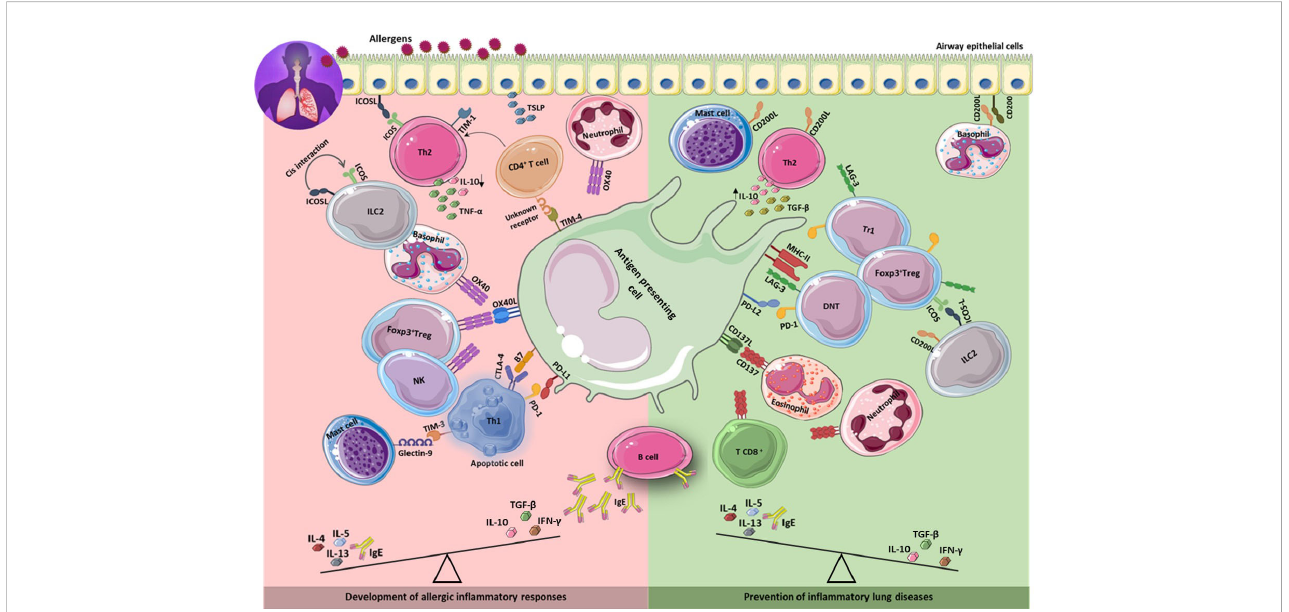
FIGURE 1 Immune checkpoints in the development and prevention of asthma. The development of asthma is associated with increased Th2 response results in secretion of IL-4, 5, 13, and IgE production. Inhibitory and stimulatory immune checkpoint molecules expressing on different immune cells as well as on lung epithelium, contribute to development (left) or prevention (right) of allergic in fl ammatory responses through interaction with their ligands on different cell types including APCs. Th2: T helper 2; IL: